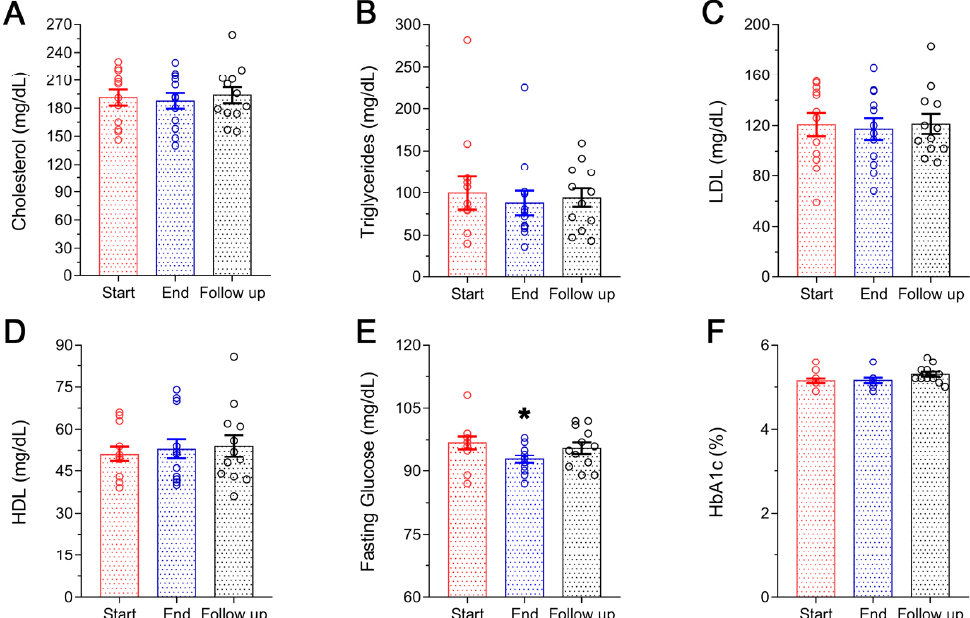
Figure 2. Lipid profile and glucose homeostasis of the subjects during the study. No significant changes were observed in the lipidemic profile of the volunteers following Antiox-Plus treatment ( A – D ). Serum levels of FBG were significantly decreased following Antiox-Plus supplementation ( p < 0.05). Glucose levels were reset to pro-supplementation levels at follow-up ( E ). HbA1c levels remained stable throughout the study period ( F ). The dots represent individual measures in 12 blood samples from healthy volunteers each time. Statistically significant difference from Start (Day 0) is shown as * ( p <